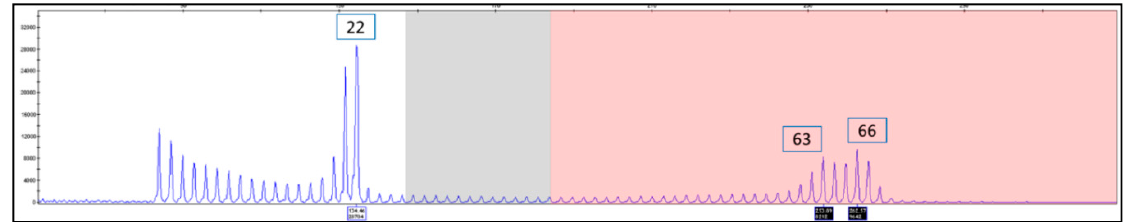
Figure 2. HTT PCR/CE analysis of NA20252 shows an additional peak (63 CAG) beyond the reference genotype of 22/66.